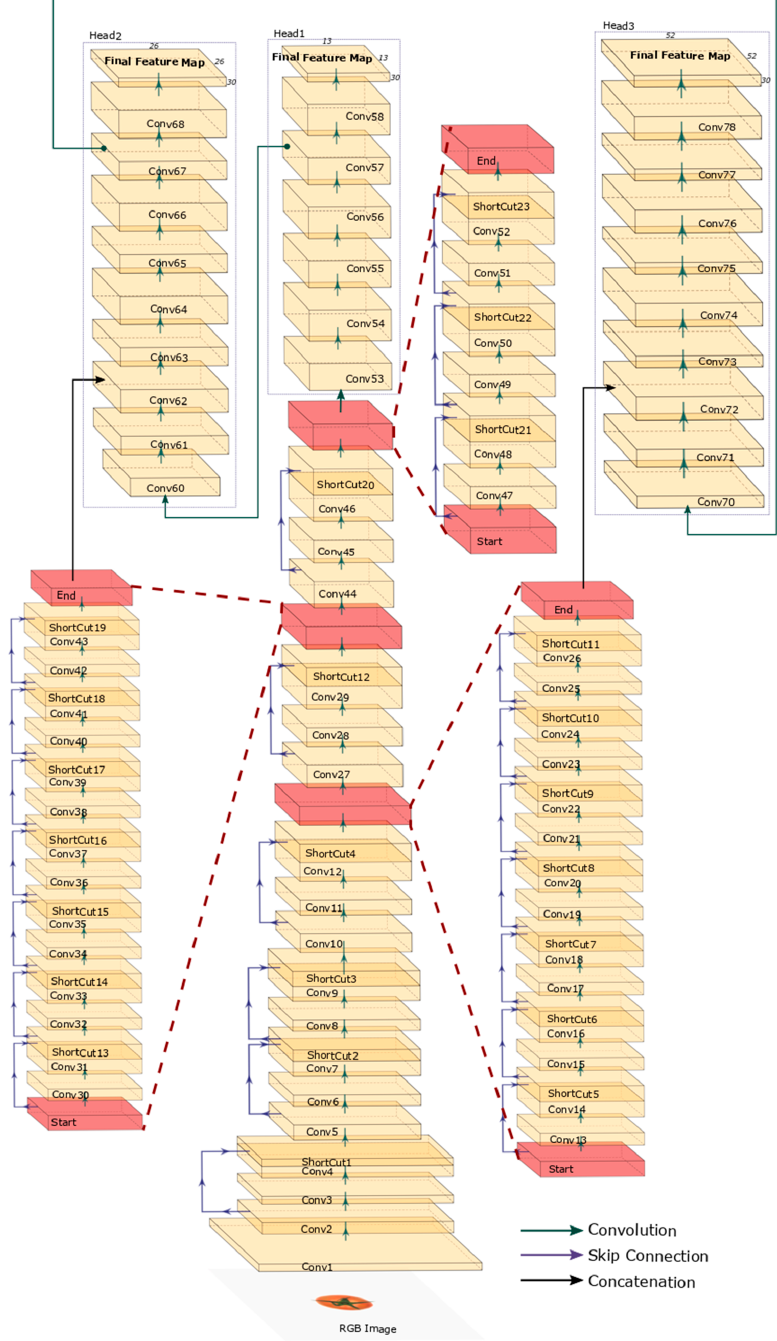
Figure 3. Visualization of backbone architecture for tomato ripeness detection.